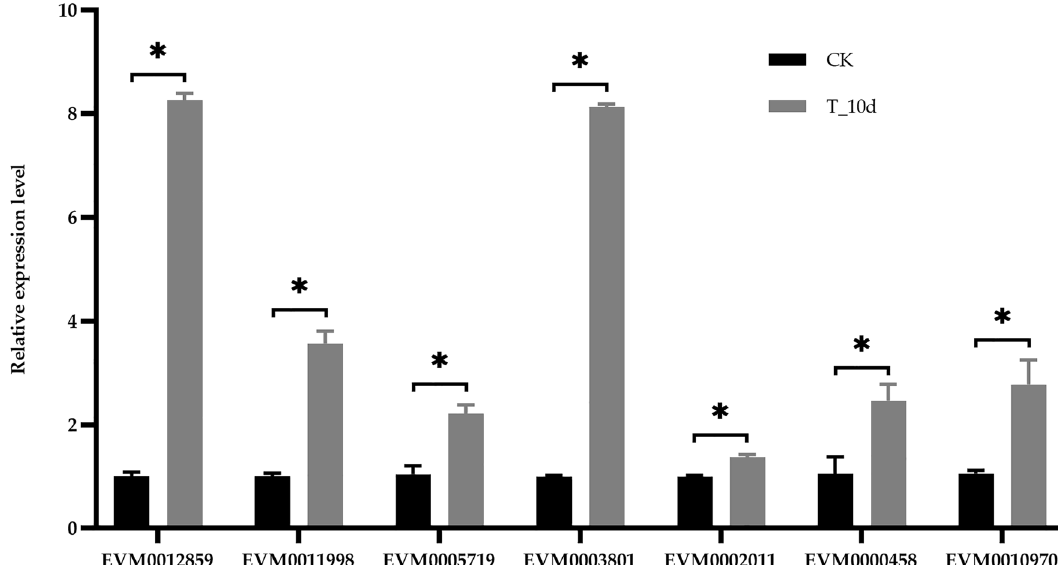
Figure 4. Expression validation of selected genes by